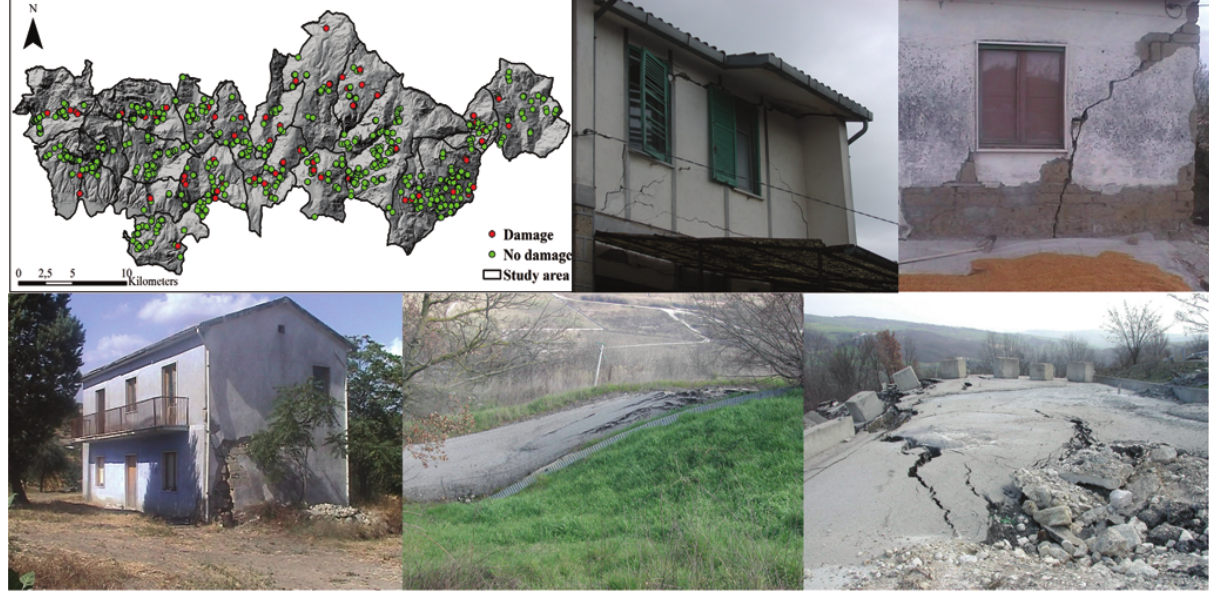
Fig. 5. Distribution of landslide-induced damages within the test area and some examples of damages recorded to buildings and